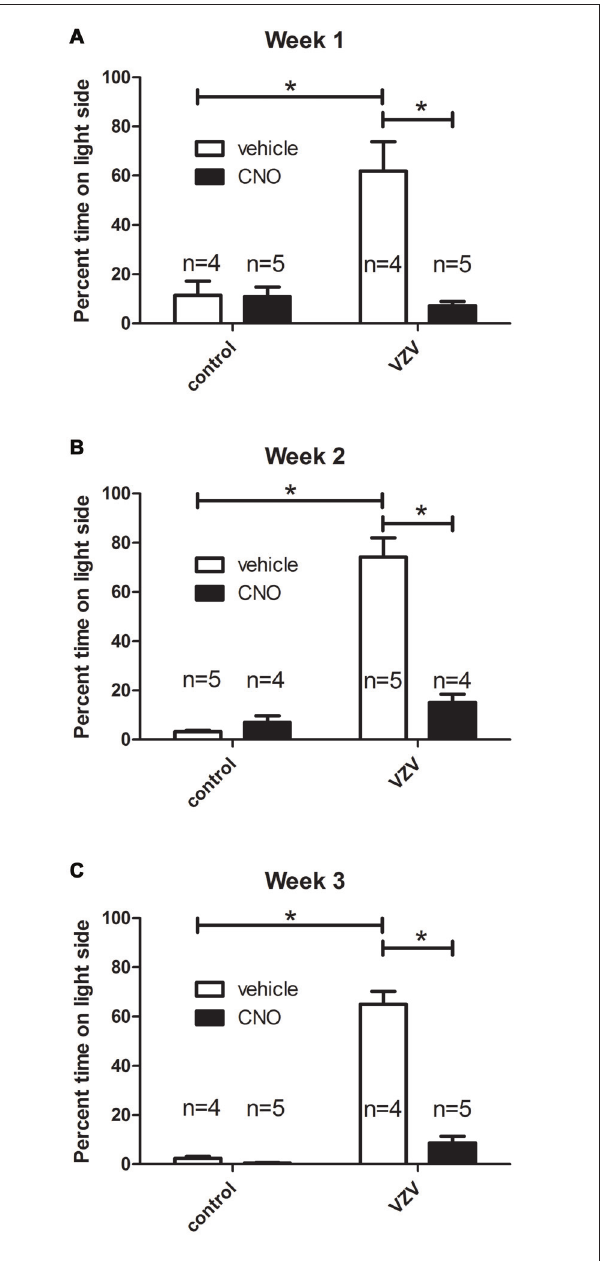
FIGURE 2 | Experiment 2, the orofacial affective pain was elevated after injecting the left whisker pad with VZV. Graphs show the percentage of time spent on the light side of the PEAP testing chamber compared to the dark side of chamber by week. A greater percent of time spent on the light side indicated a greater affective pain. The right ventral posterior medial/posterior lateral thalamus (VPM/VPL) was infused with of adeno-associated virus (AAV8)-hSyn-hM4D(Gi)-mCherry and 1 week later the left whisker pad was injected with VZV or the control (MeWo cells without virus). Thirty minutes before PEAP testing the rats were given an injection of either clozapine-n-oxide (CNO) or vehicle (0.9% saline). Testing was completed once a week for 30 min for three consecutive weeks (A–C) . The number of rats in each group is shown on the graphs. The animals receiving CNO or saline were reversed from week to week. Asterisk indicates a significant difference of p < 0.05. The values are the mean ±